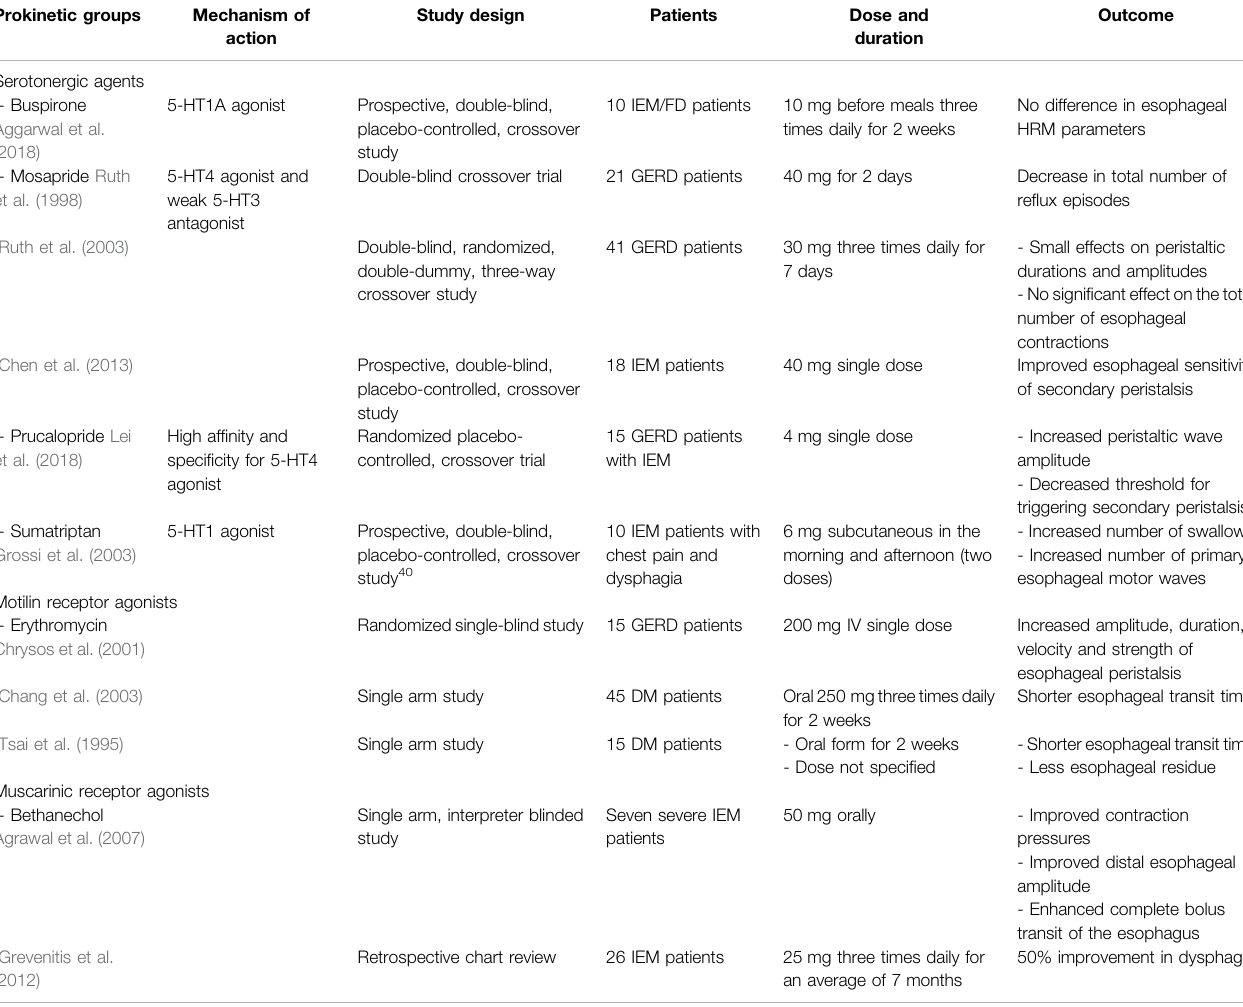
TABLE 1 | Potentially bene fi cial prokinetic medications for esophageal hypomotility that have been studied in patients. Prokinetic